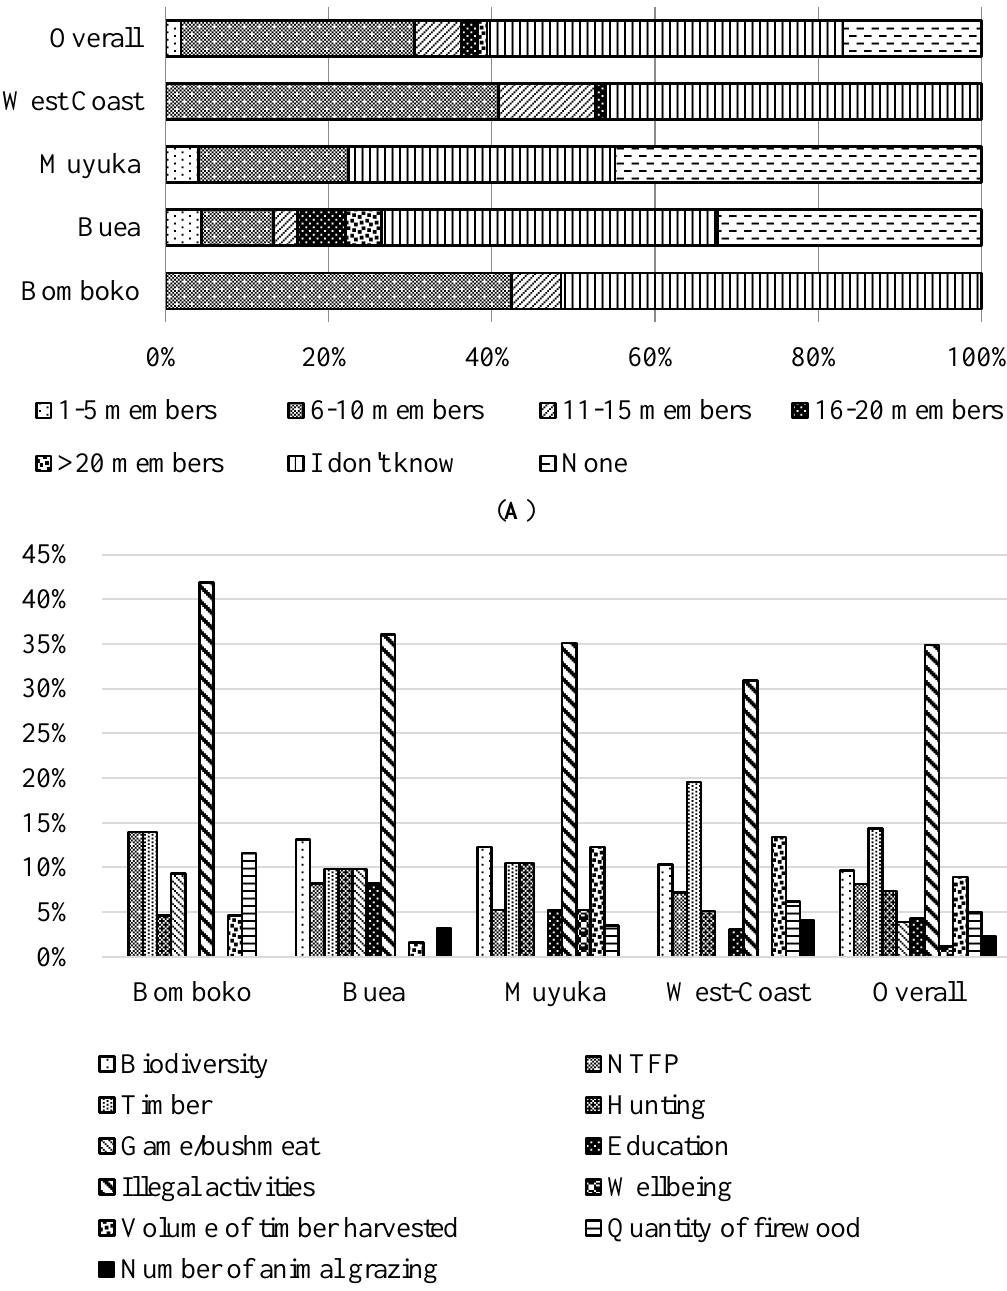
Figure 11. Percentages of the average number of community members trained for ( A ) and types of information recorded during ( B ) MCNP activities.